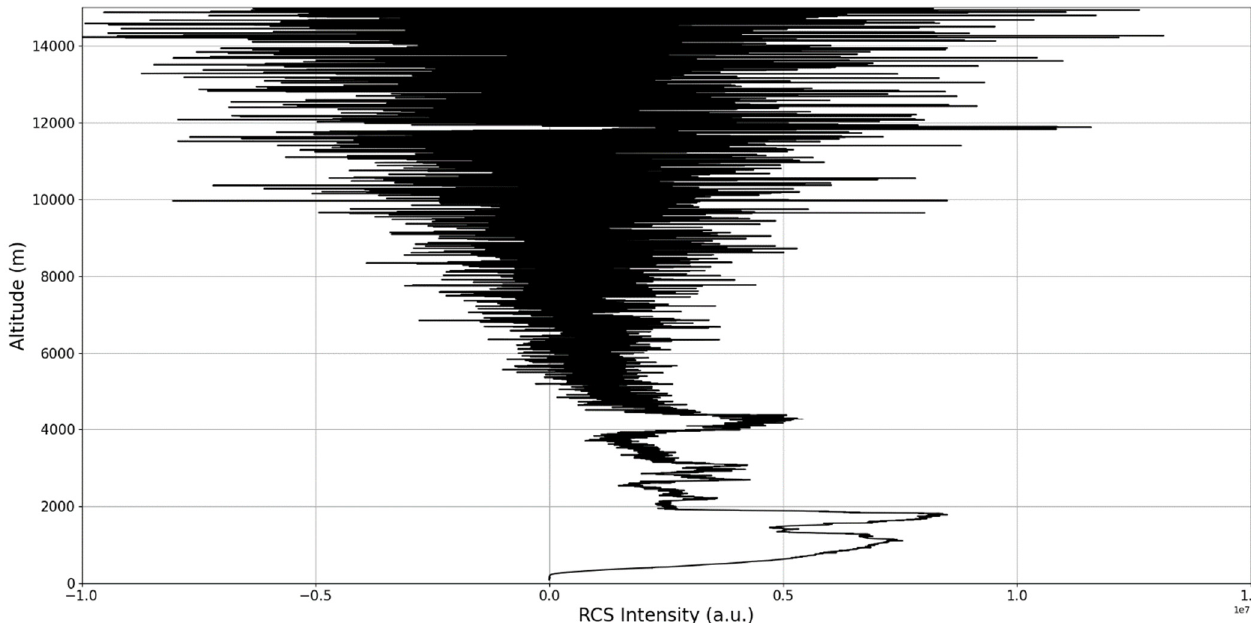
Figure 4. RCS profile corresponding to point A.